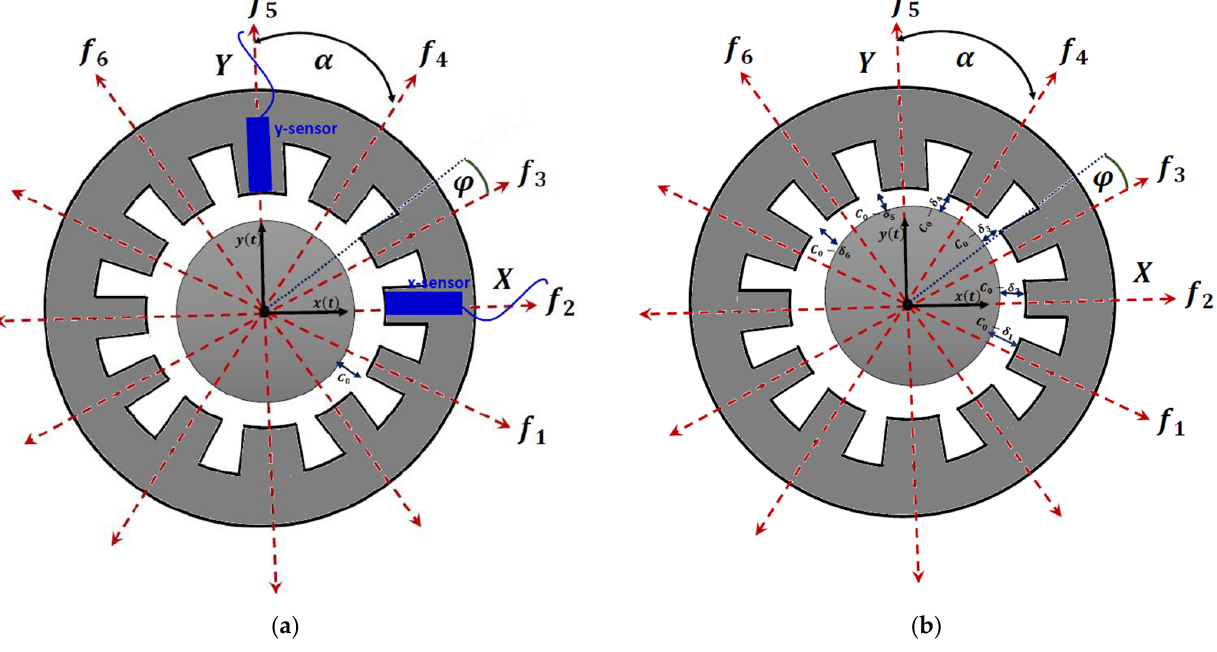
Figure 1. ( a ) twelve-poles rotor system at its nominal position, ( b ) twelve-poles rotor system with small displacements 𝑥(𝑡) and 𝑦(𝑡) in the horizontal and vertical directions, respectively.